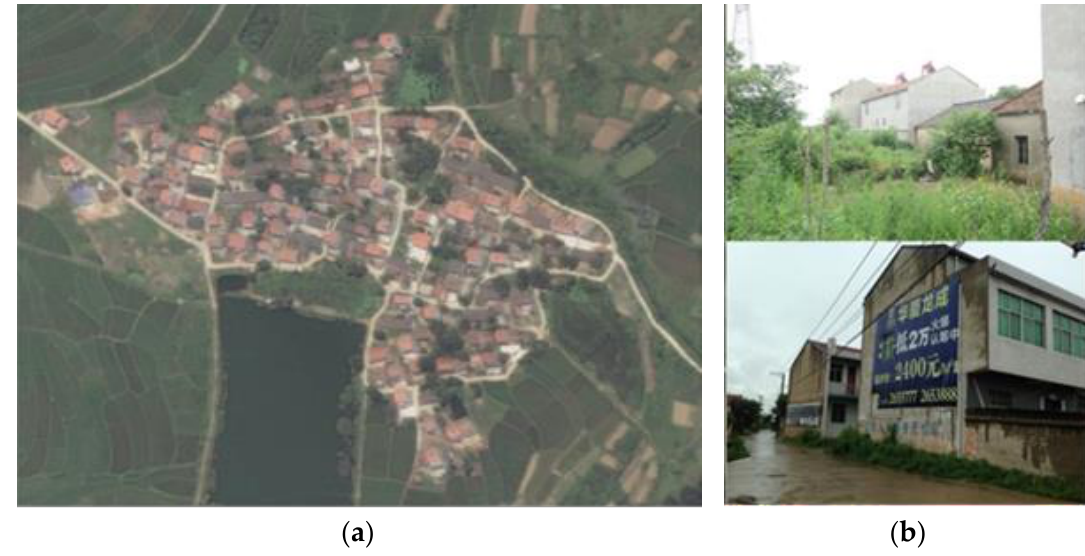
Figure 1. The study area of the Ma’anshan Village: ( a ) a satellite image covering the entire village; and ( b ) two close-up views of two residential houses in the study area.